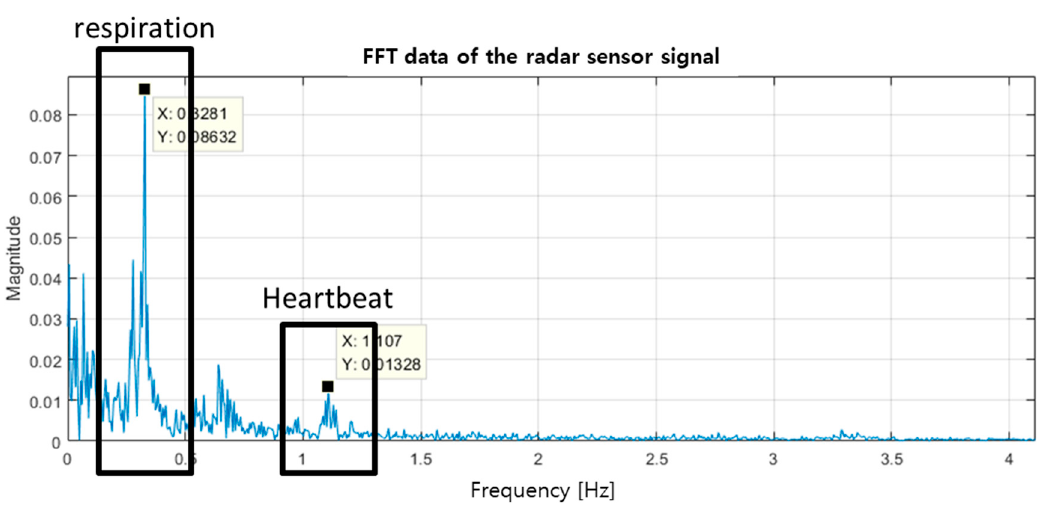
Figure 3. Respiration and heartbeat signals in the frequency domain measured using the radar sensor.